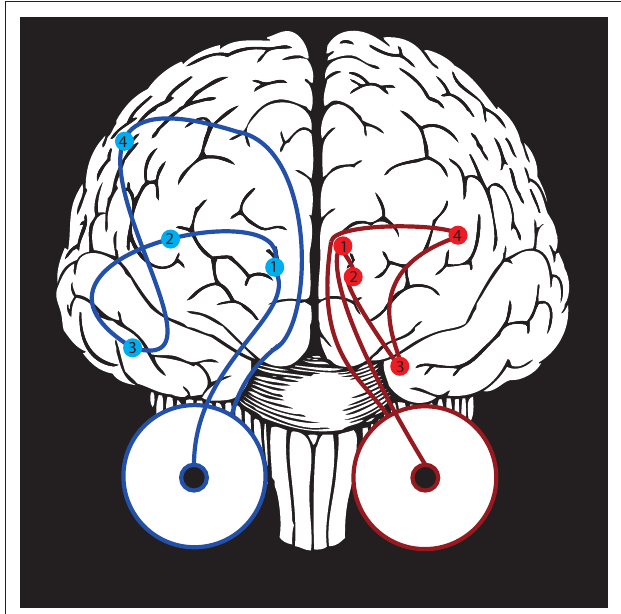
FIgure 6 | Potential mechanisms for gaze-following behavior. Two general pathways (shown here, schematically) could relate observed gaze to visual attention. At left, in blue, visual information travels from the retina to the lateral geniculate (1), the early visual areas (2), the social processing areas along the superior temporal sulcus (3), and finally toward attention control circuitry including the lateral intraparietal area, frontal eye fields, and superior colliculus (4). At right, in red, a hypothesized subcortical pathway travels directly from the retina to the superior colliculus (1), to the pulvinar nucleus of the thalamus (2), and to the amygdala (3). The subcortical pathway could influence attention locally in the superior colliculus or pulvinar, or via projections from amygdala to the early visual areas